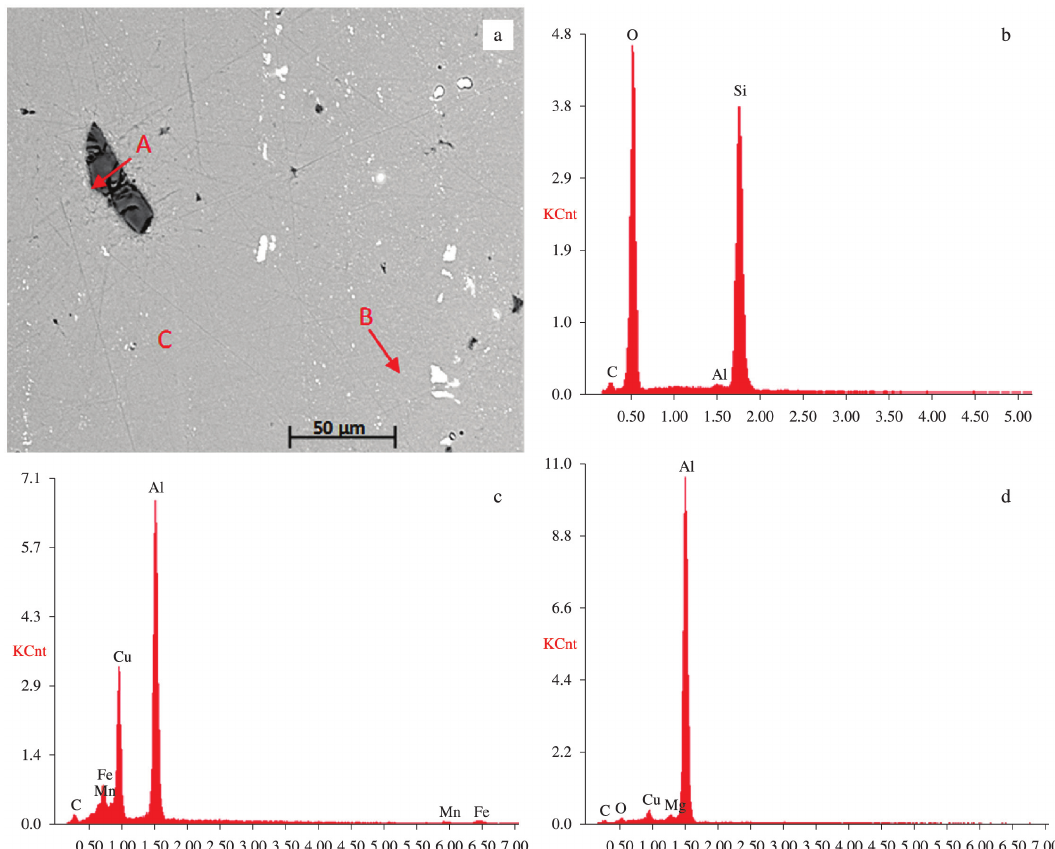
Figure 18. (a) Scanning electron micrograph of the uncoated aluminum. A (b), B (c) and C (d) are energy dispersive spectra taken from regions A, B and C marked in the micrograph. Table 2. Results for the semi-quantitative analysis of 2024 aluminum alloy. Semi-quantitative region